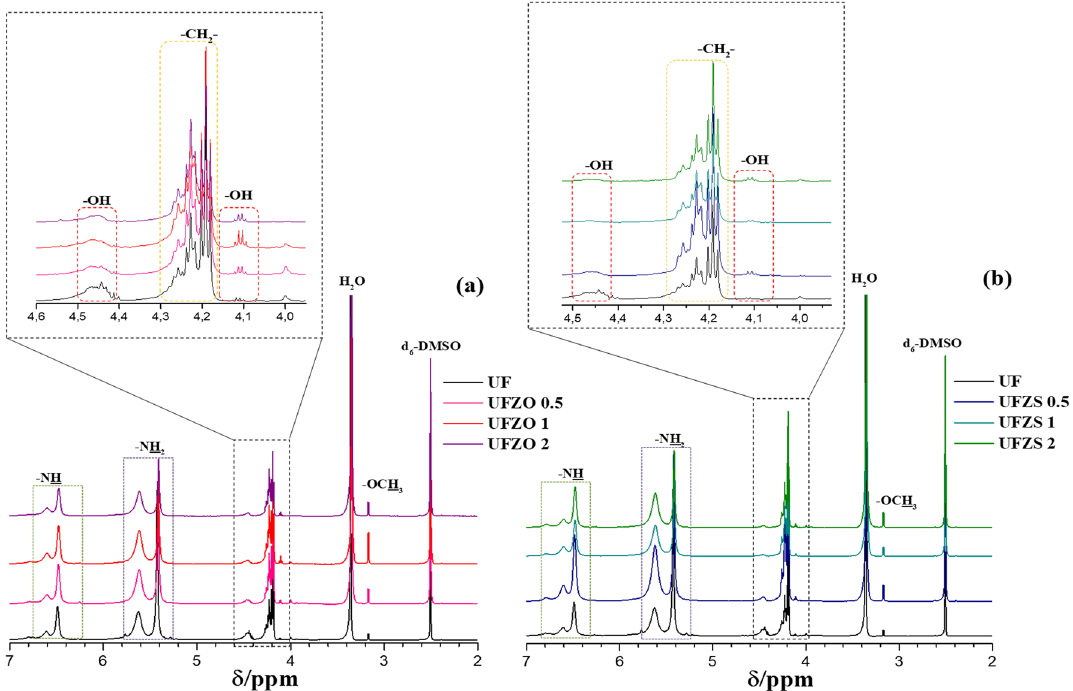
Figure 5. 1 H NMR spectra of UF and composites ( a ) UFZO and ( b ) UFZS solubilized in d 6